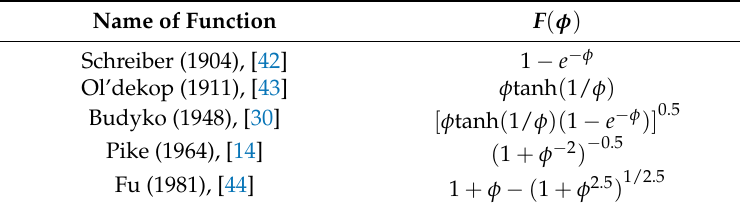
Table 1. Commonly used Budyko